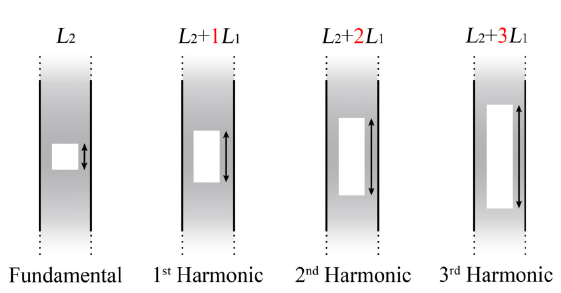
Figure 15. Schematic diagram of the relationship between the length of the reference interferometer ( L 2 + iL 1 ) and the sensing interferometer ( L 1 ), where i corresponds to the order of the harmonic [8].